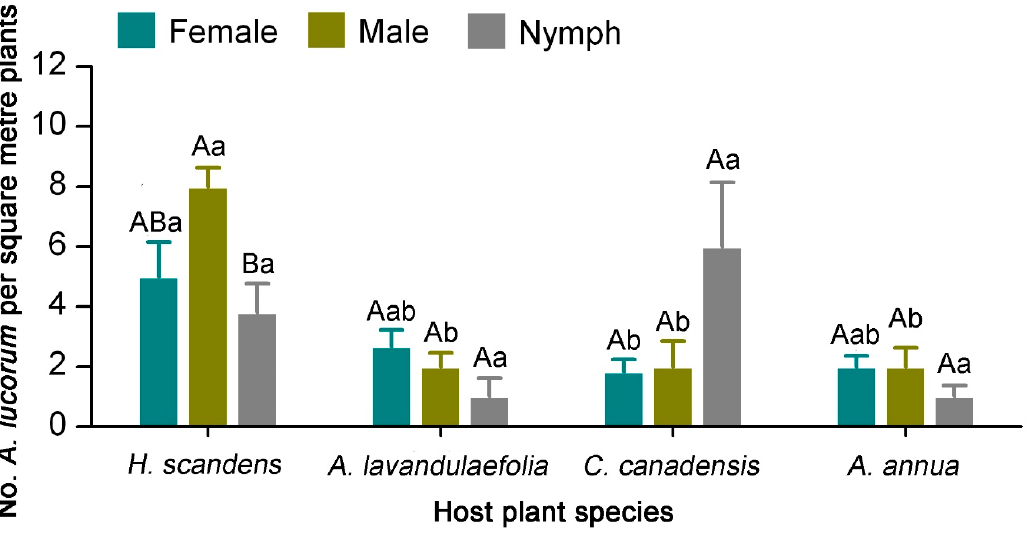
Figure 4. Number of females, males, and nymphs of A. lucorum on four different host plants in tea plantation. Different uppercase letters indicate significant differences among males, females and nymphs and different lowercase letters indicate significant differences among different host plants (Tukey’s HSD test, p < 0.05).